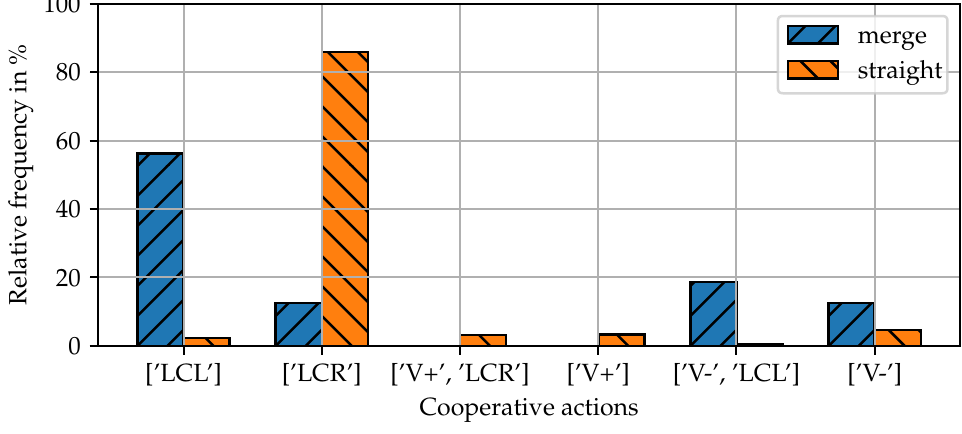
Figure 7. Relative frequency of cooperative